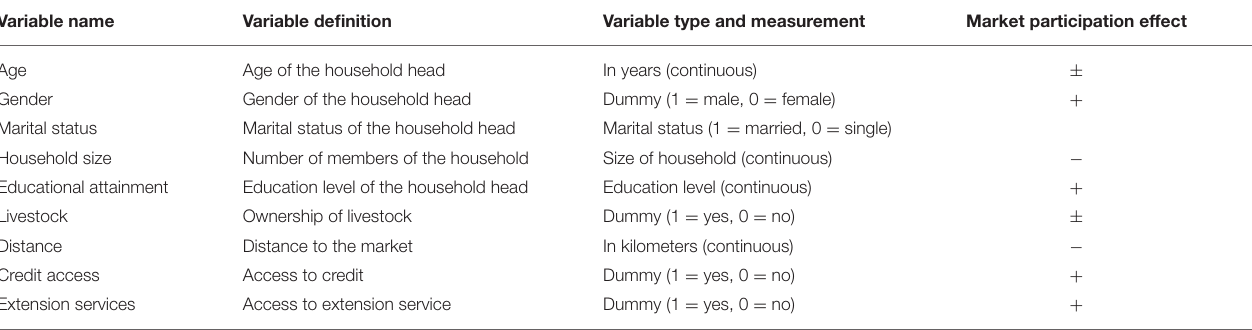
TABLE 2 | Estimated factors that affect the smallholder farmers’ decisions for market